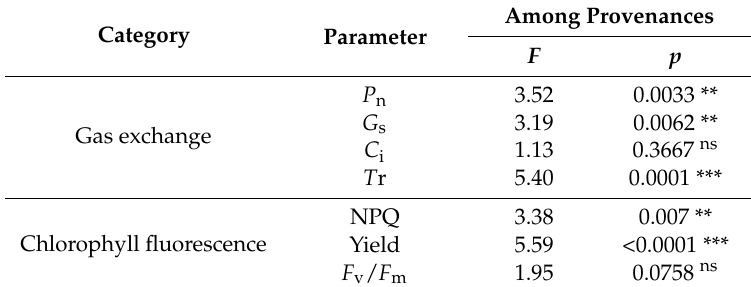
Table 6. Variance analysis of photosynthetic parameters among teak clones from different provenances. Category